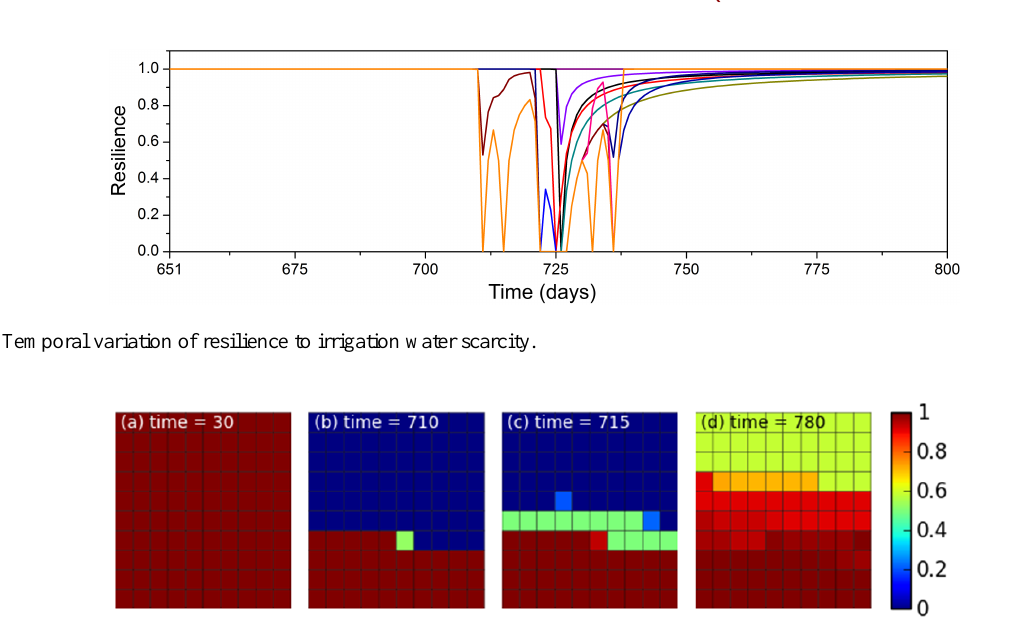
Figure 4. Spatial variation of resilience to irrigation water